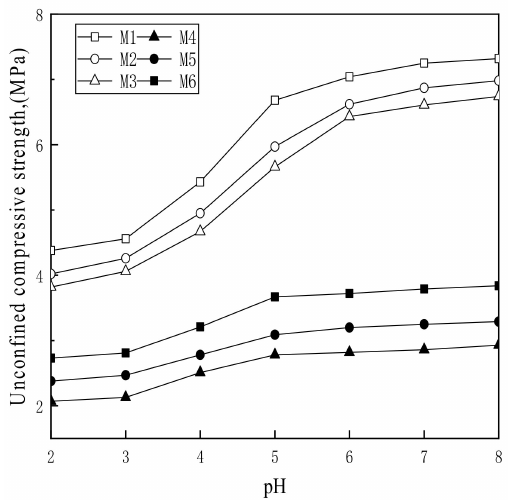
Figure 1. 7-day unconfined compressive strength (UCS) of CPCM and cement-PG stabilized soil at di ff erent PG pH values.